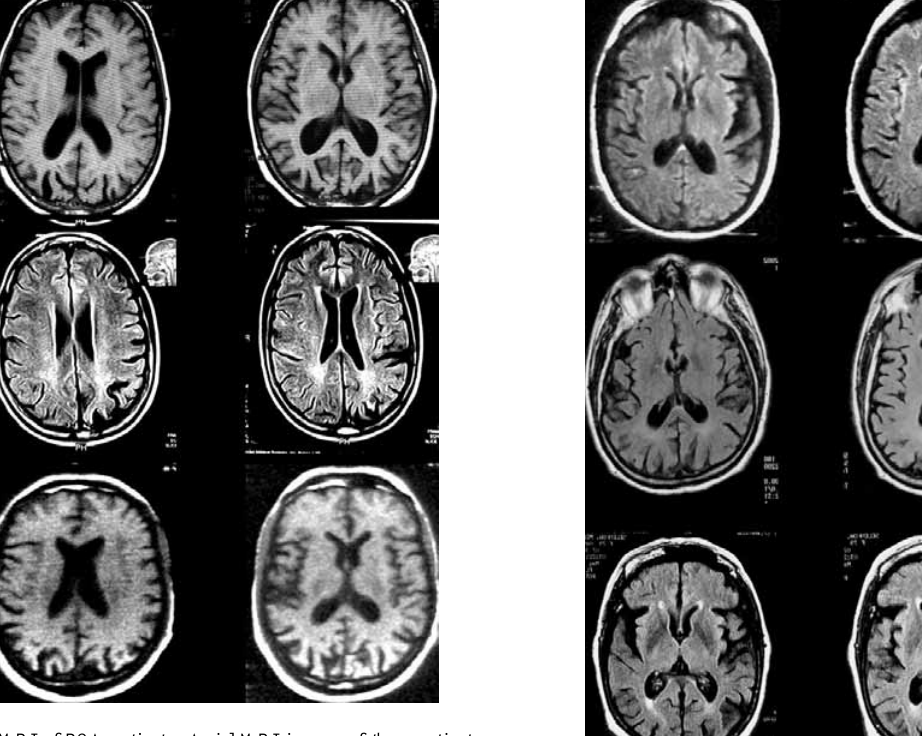
Fig. 1. MRI of PCA patients. Axial MRI images of three patients withPCA,illustratingmarkedoccipitalandposteriorparietalatrophy. evaluated all MRI, CT, PET, and/or SPECT imaging scans.